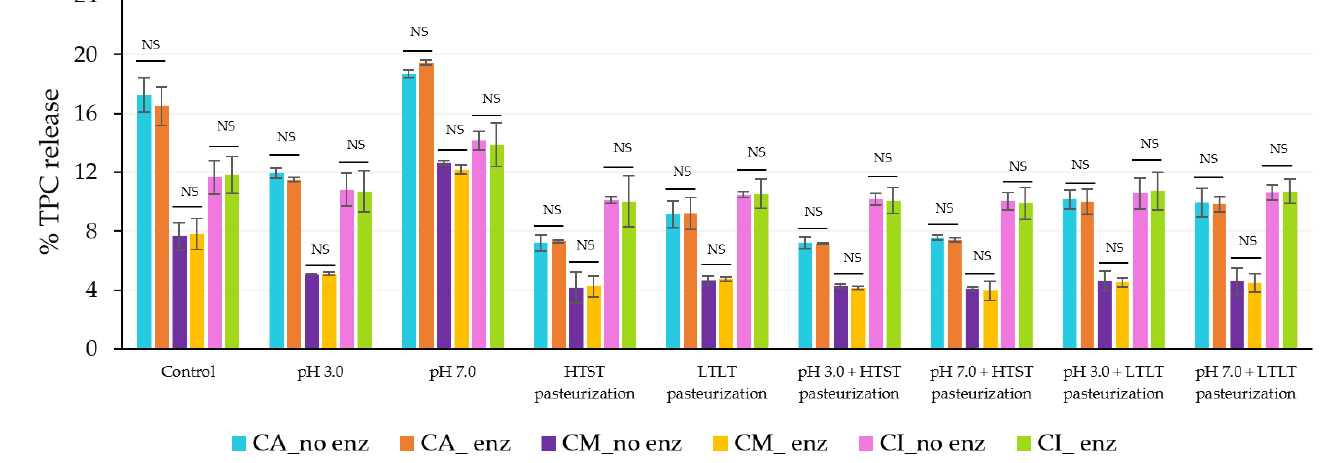
Figure 10. % TPC released during simulated gastrointestinal conditions in the intestinal phase (120 min) with and without pancreatic and bile salts. NS indicated no significant differences at p ≤ 0.05. The error bars indicate the SD of the data. The control sample was microbeads after air-drying.